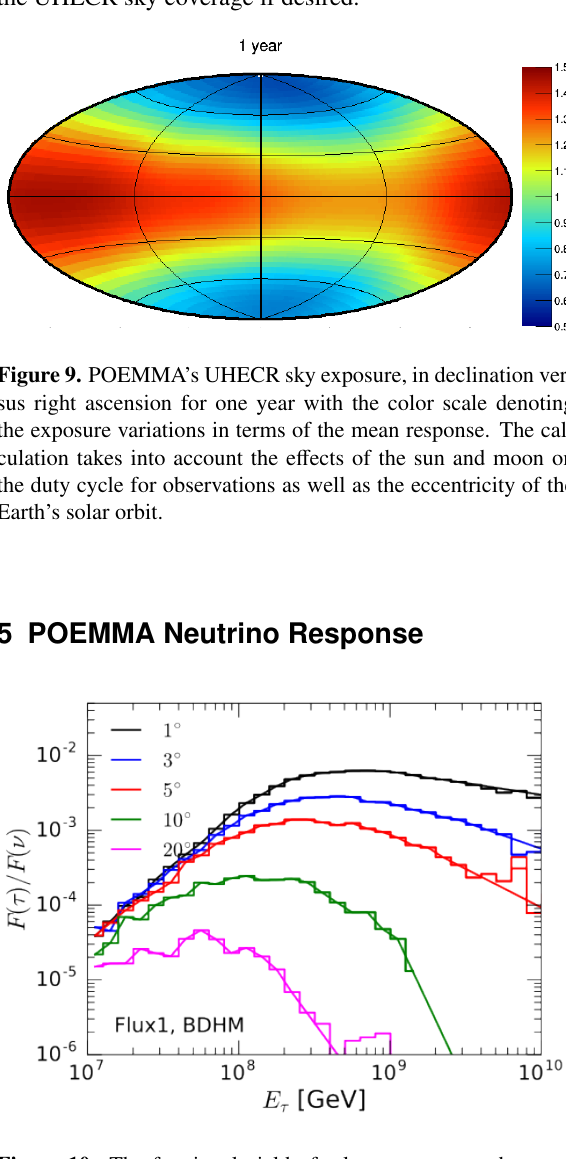
Figure 10. The fractional yield of τ -leptons compared to cos- mogenic neutrino energy as a function of energy and Earth emer- gence angle assuming a mixed nuclear composition UHECR flux from [19]. From Ref.